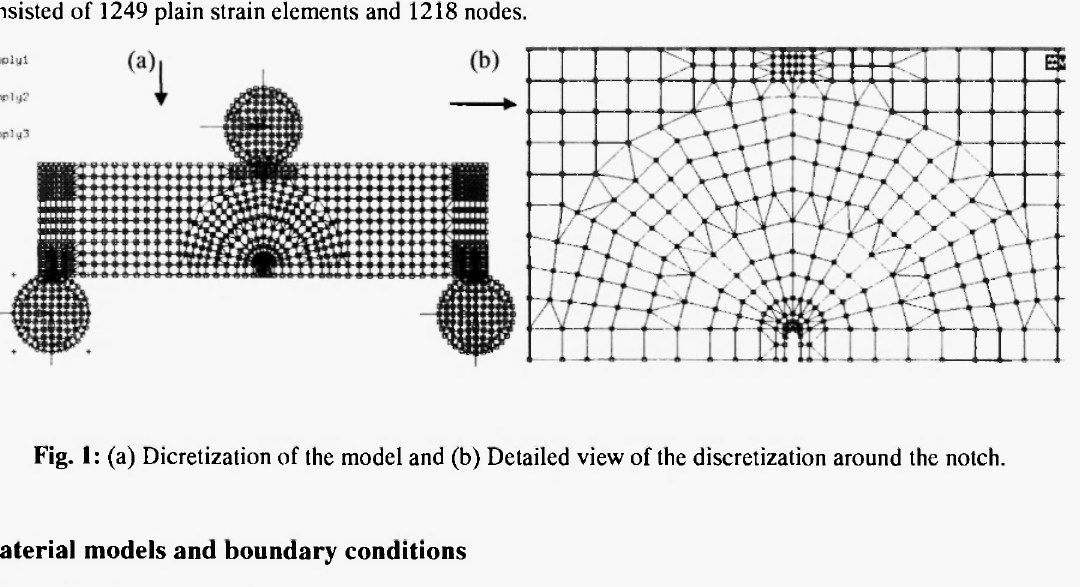
Material models and boundary